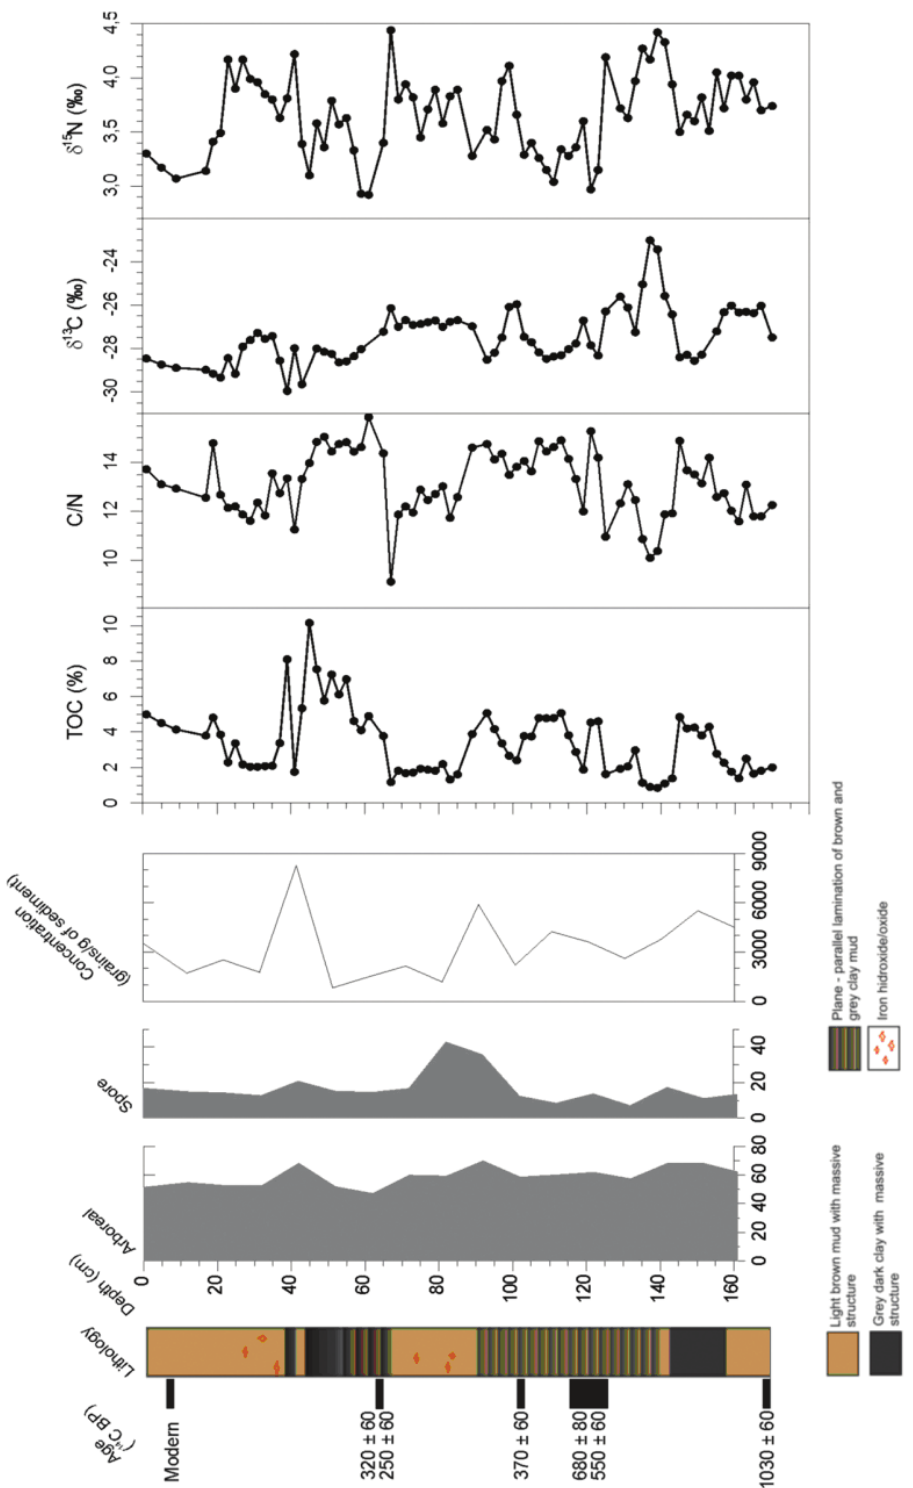
Fig. 2 – Concentrations of arboreal pollen, spore, grains/g of sediment, total organic carbon, C/N ratios, δ 13 C and δ 15 N values from Lagoa